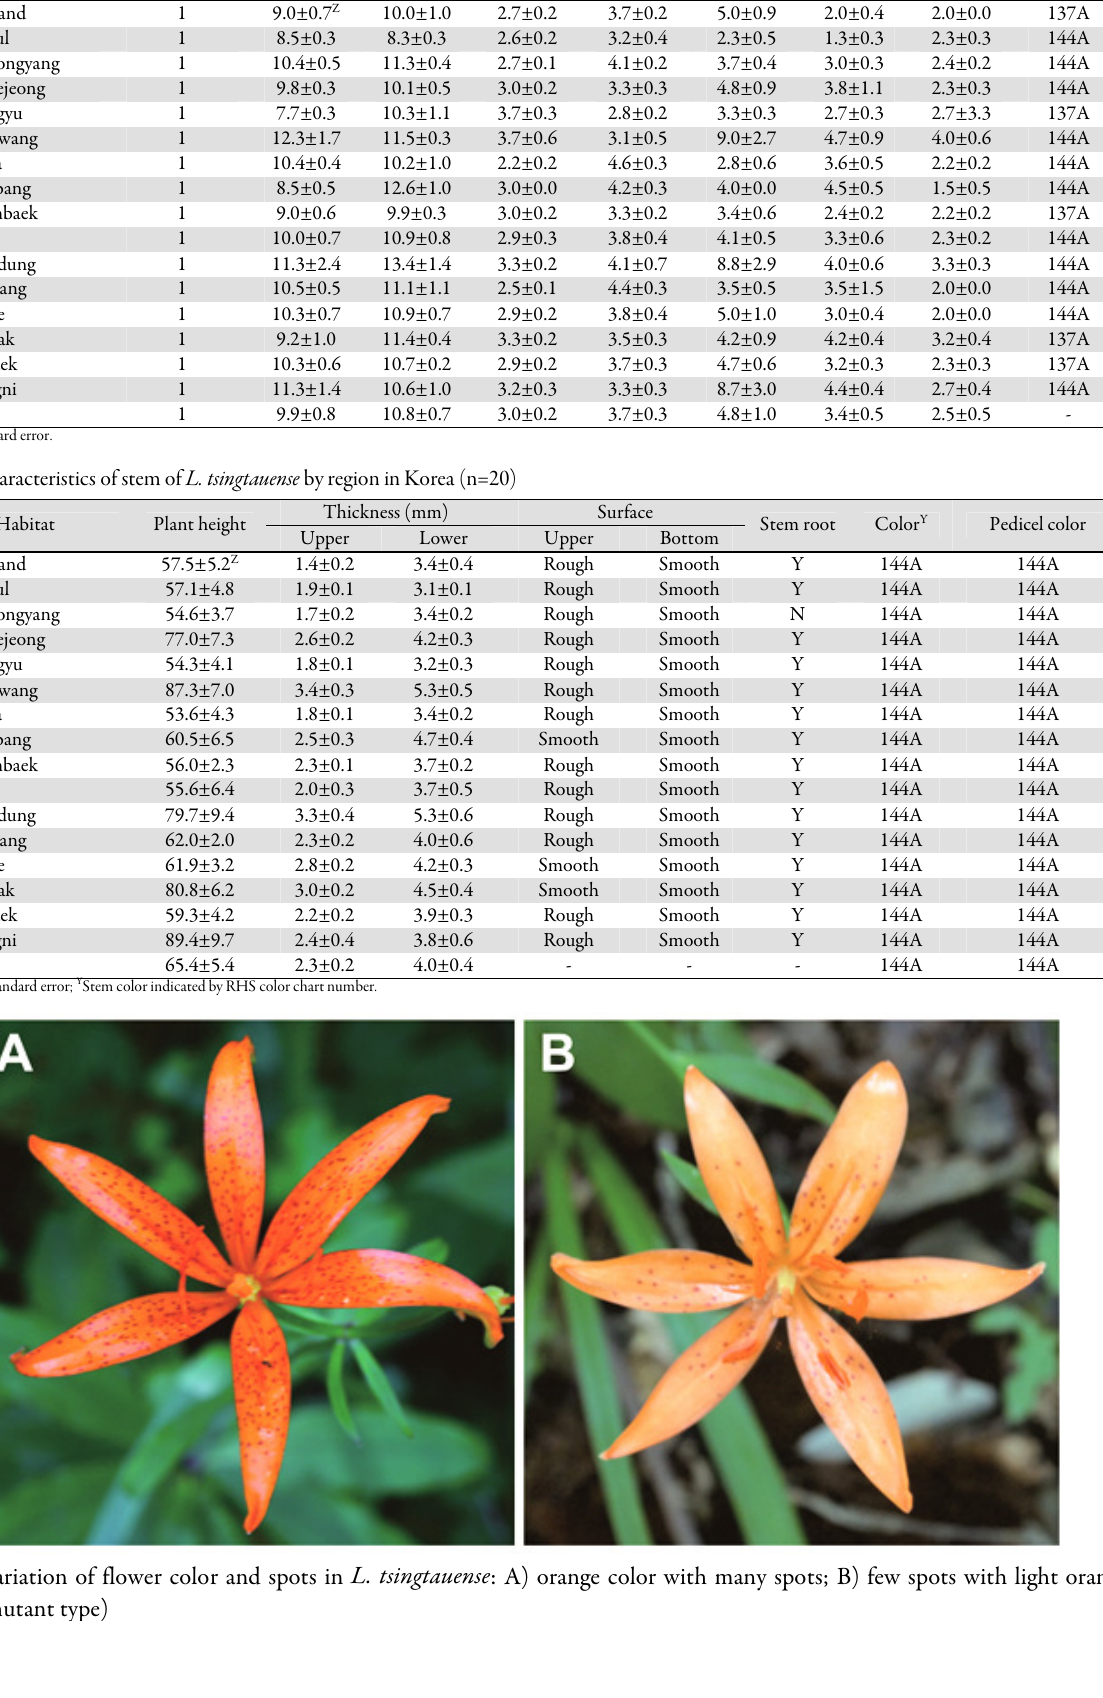
Tab. 3. Characteristics of leaf of L. tsingtauense by region in Korea (n=20)